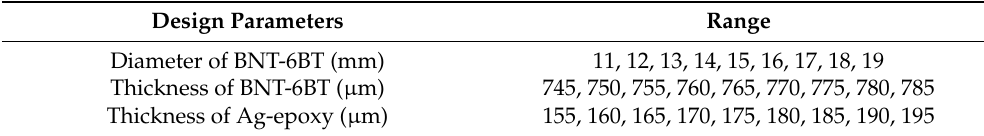
Table 1. Design parameters of ultrasonic